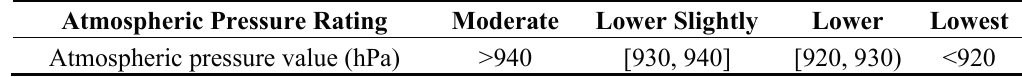
Table 1. Fuzzy classification of atmospheric pressure.